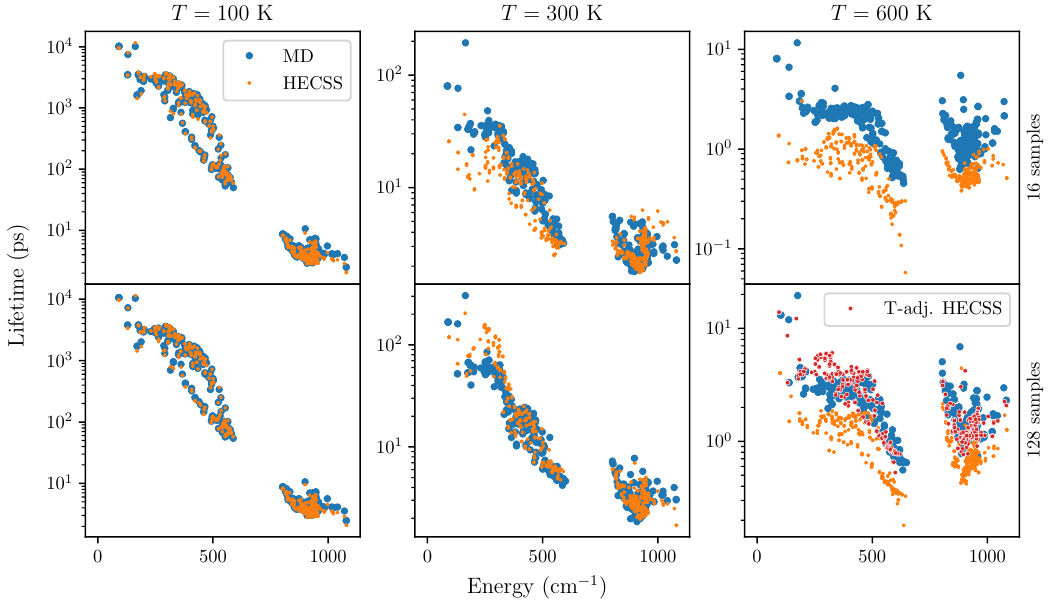
Figure 6: Consistency and convergence of 3C-SiC phonon lifetimes derived with third order model based on MD (blue) and HECSS (orange and red) generated data. The data corresponds to three temperatures T = 100, 300 and 600 K. Two sample sizes used are: 16 – enough to obtain well-converged phonon frequencies (see Fig. 5) and 128 – selected after convergence testing of the obtained lifetimes. The red dots indicate lifetimes obtained by lowering the temperature in HECSS procedure by 90